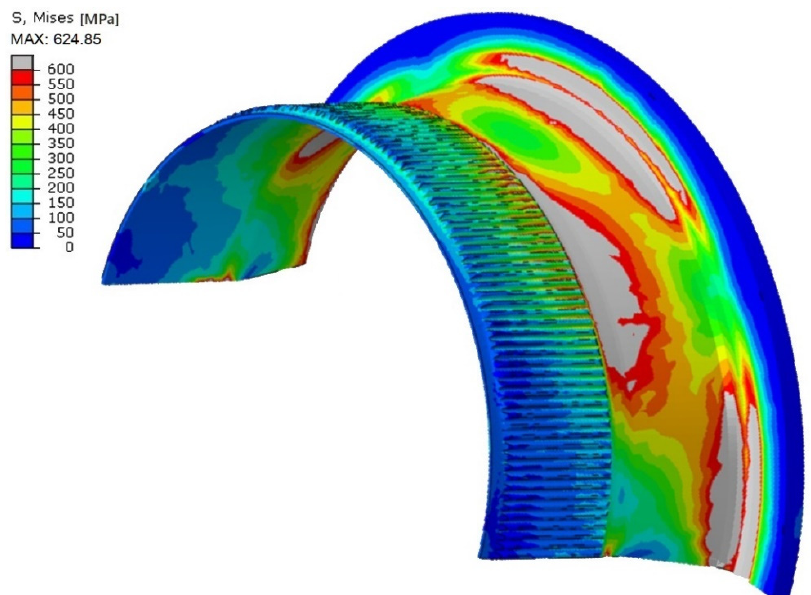
Figure 10. The distribution of the stresses in the flexspline model—variant VI.